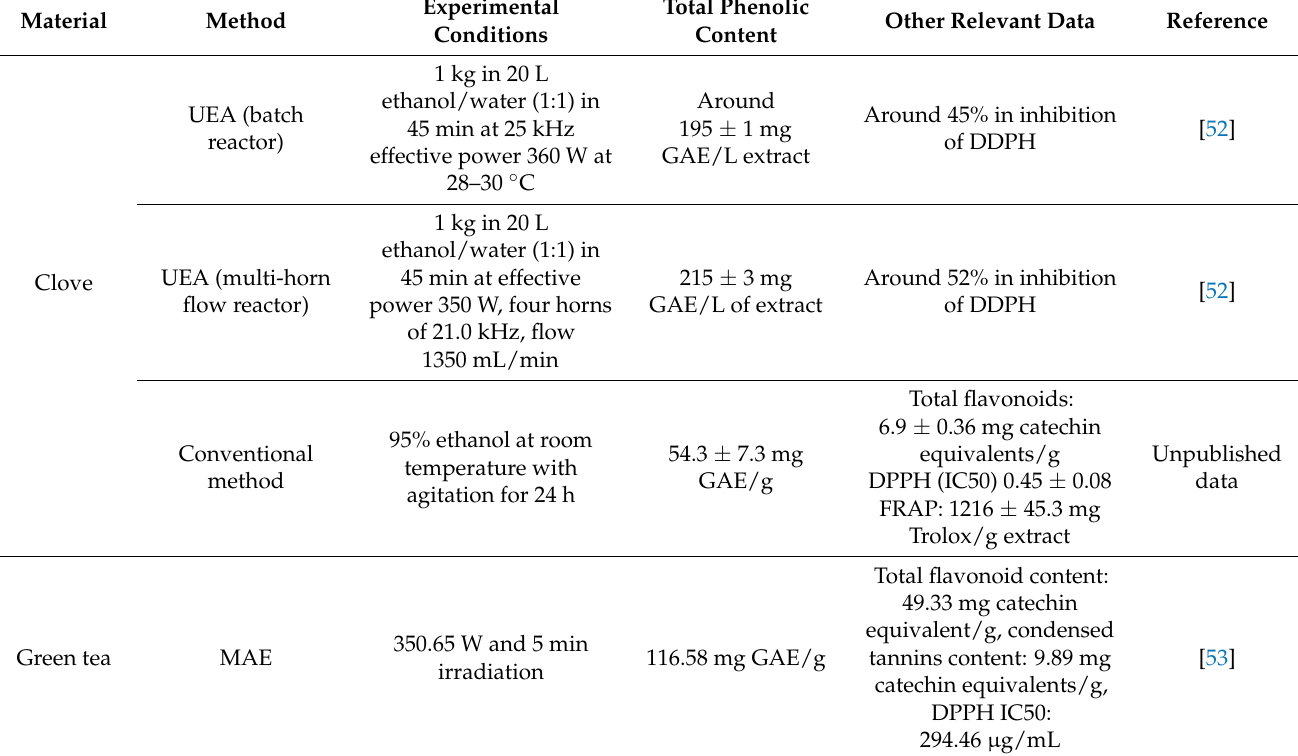
Table 2. Polyphenol extraction from some spices using environmentally friendly techniques. Material Method